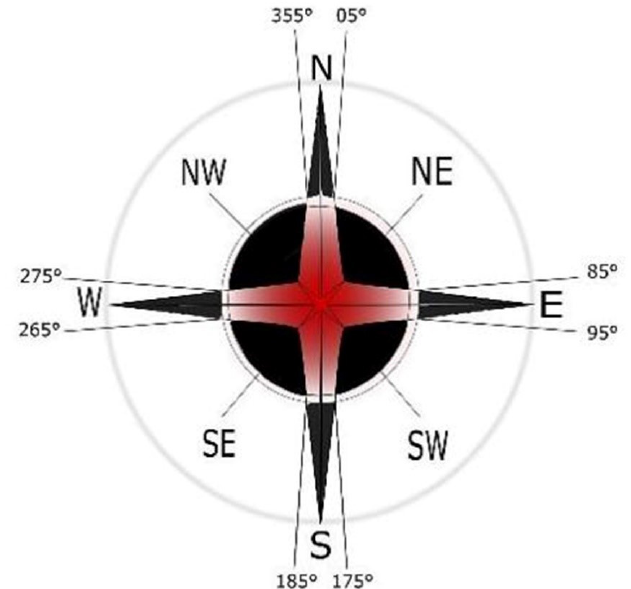
Figure 2. Illustration of ranges of azimuthal classes adopted in this